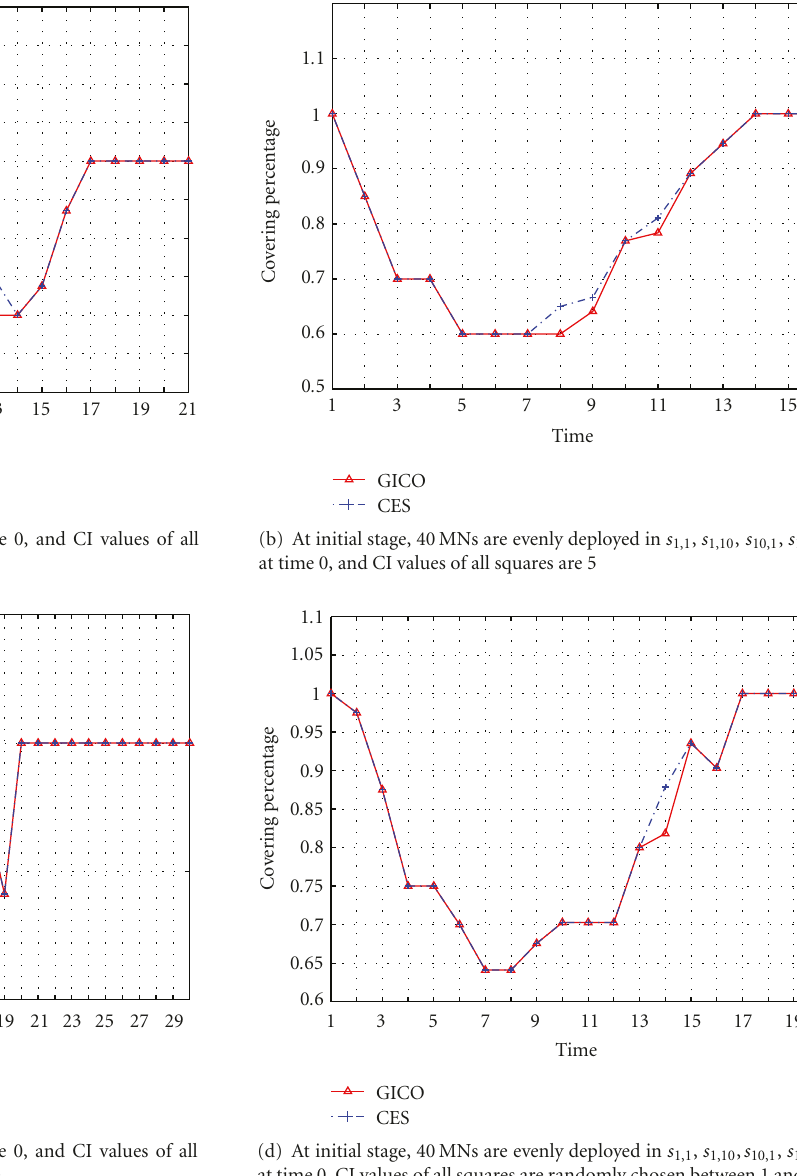
Figure 7: The covering percentage over the entire disaster area relief process in four scenarios. r = 1 . 5 L , C = 10, M =